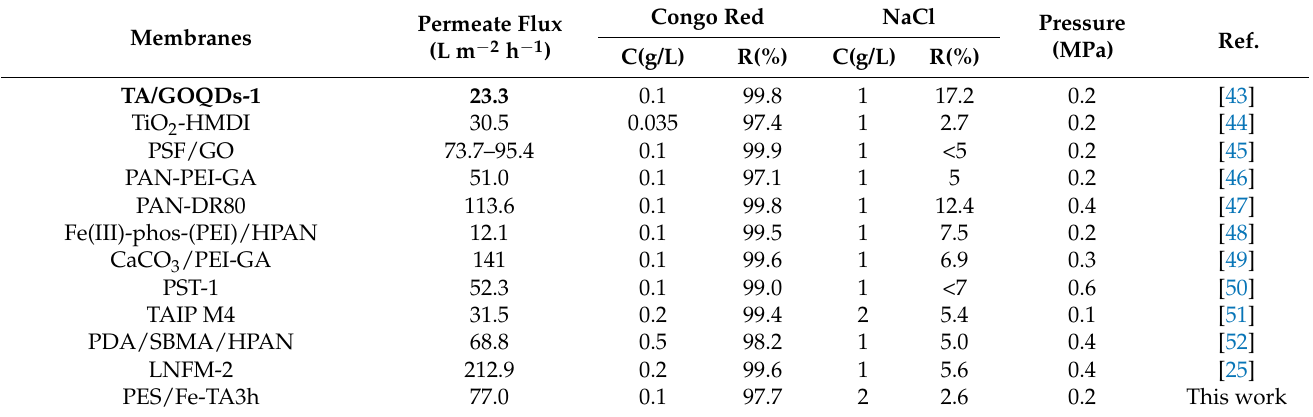
Table 1. Comparison of the performance of the NF membranes in the